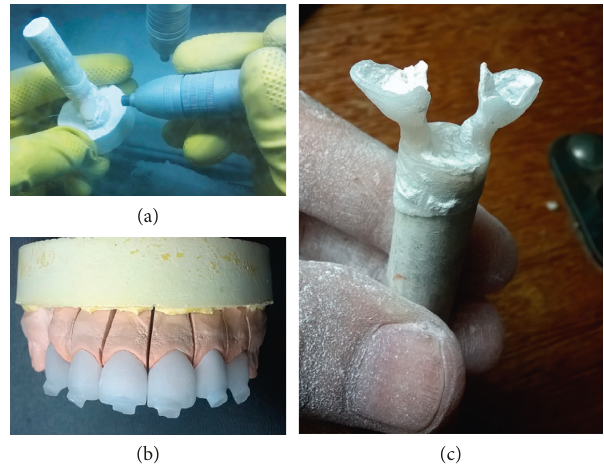
Figure 13: (a) Removal of the laminates from the coating mold using shot blasting with glass microspheres; (b) ceramic pieces placed in the plaster model, still with the remnants of the feed channels; (c) view of the injected parts attached to feed channels.